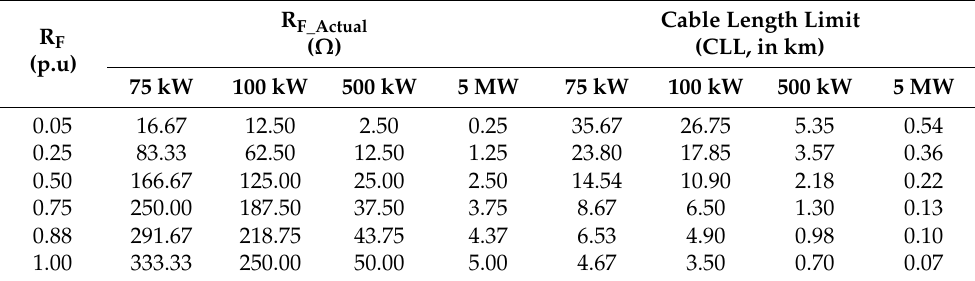
Table 5. Summary of identified CLLs versus power delivery